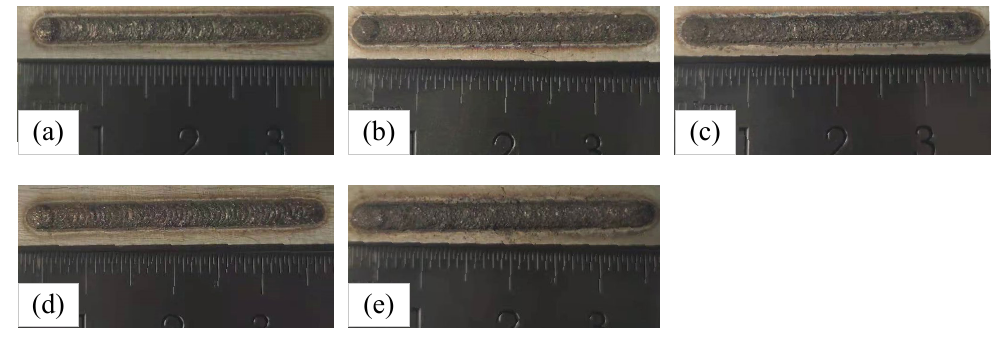
Figure 3. Images of single-track clads deposited by LAM with ( a ) continuous, ( b ) rectangular, ( c ) ramp up, ( d ) ramp down, and ( e ) hybrid ramp laser shape. up, ( d ) ramp down, and ( e ) hybrid ramp laser